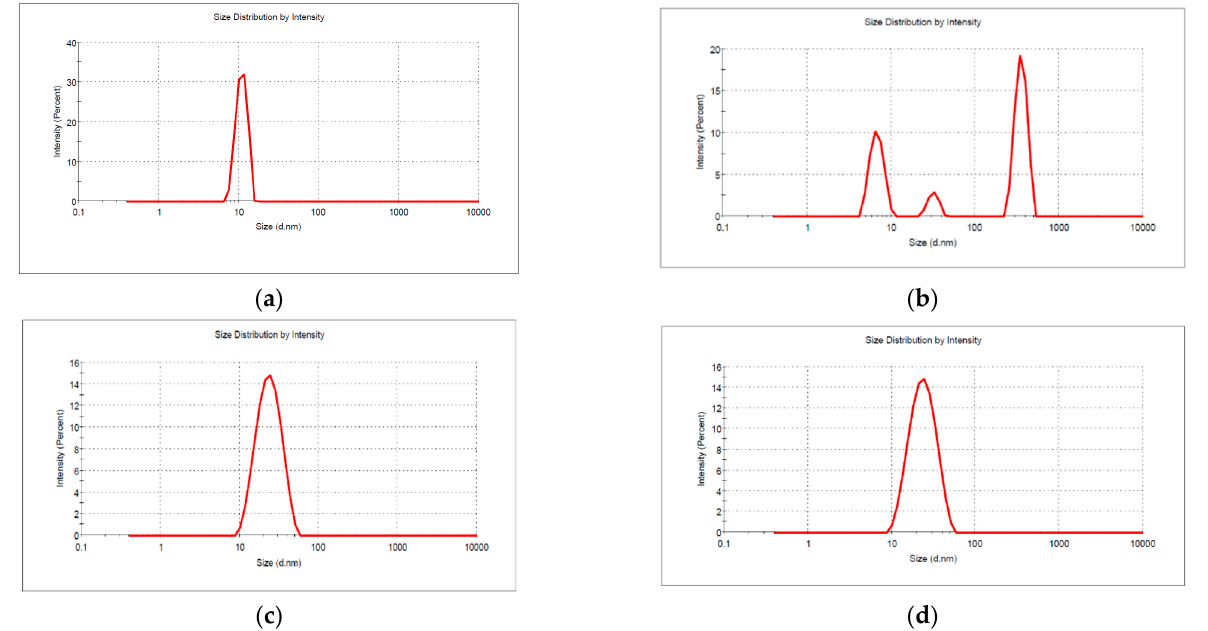
Figure 2. Size and size distribution of the micelles: ( a ) Cremophor EL, ( b ) Pluronic F127, ( c ) Mixed Cremophor EL-Pluronic F127 micellar system, ( d ) Norfloxacin loaded mixed Cremophor EL-Pluronic F127 micellar system.